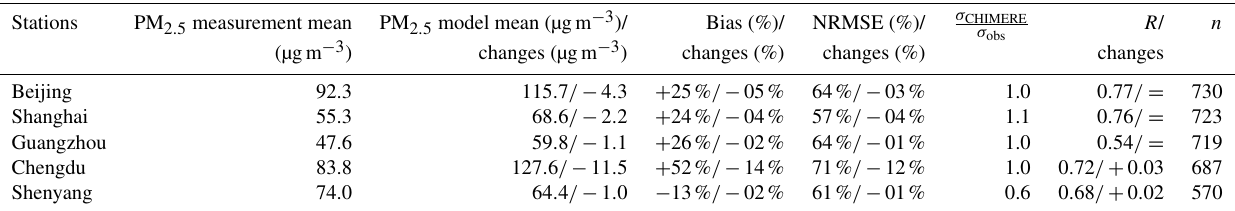
Figure 11. (a) Evolution of NO x( g ) , SO 2 ( g ) , NH 3 ( g ) and HNO 3 ( g ) tropospheric columns (moleculescm − 2 ) for 2011A, 2013C and 2015C over the eastern China domain. (b) Evolution of NH + , SO 2 − , NO − and pSNA tropospheric columns (moleculescm − 2 ) from 2011 to 4 ( p ) 4 ( p ) 3 ( p ) 2015 over the eastern China domain. Table 3. Daily PM 2 . 5 comparison between model and measurements for 2013C and 2015C simulations. “Changes” corresponds to differ- ences between 2013C and 2015C comparisons on the one hand and 2013A and 2015A on the other (i.e. bias changes = bias C − bias A ). Bias and NRMSE are normalized using the measurement mean. R corresponds to the Pearson correlation coefficient and n represents the number of available daily